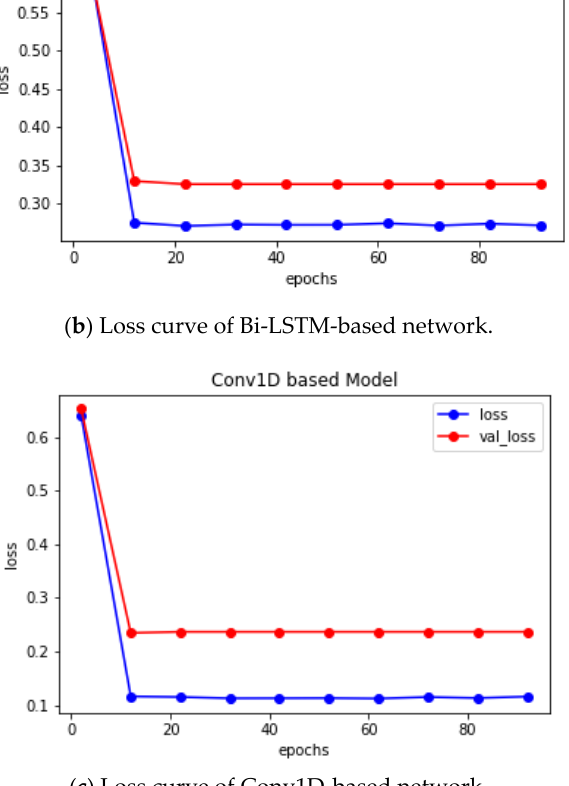
Figure 6. ( a – e ) Pictorial representation of epochs versus the loss of different networks for training and validation dataset.